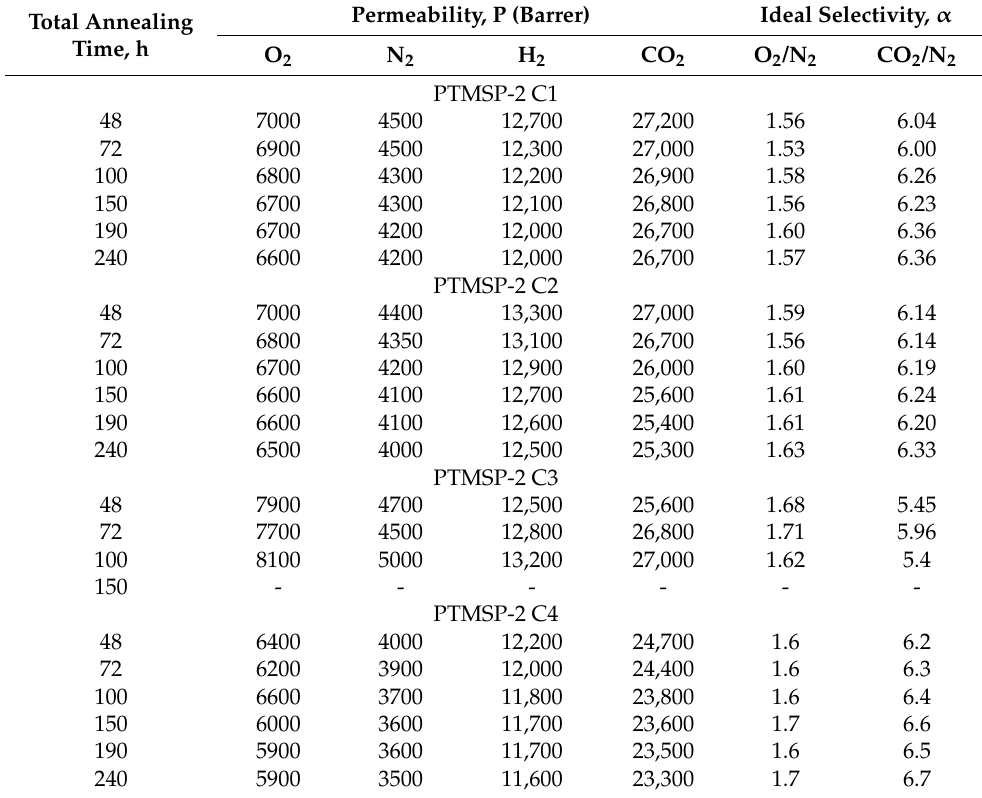
Table 4. The change in permeability coefficients of PTMSP-2 films containing stabilizers Irganox 1010 (C1), Vulkanox BKF (C2), Vulkanox BHT (C3), and Irganox 1076 (C4) during heat treatment (T = 140 ◦ C).